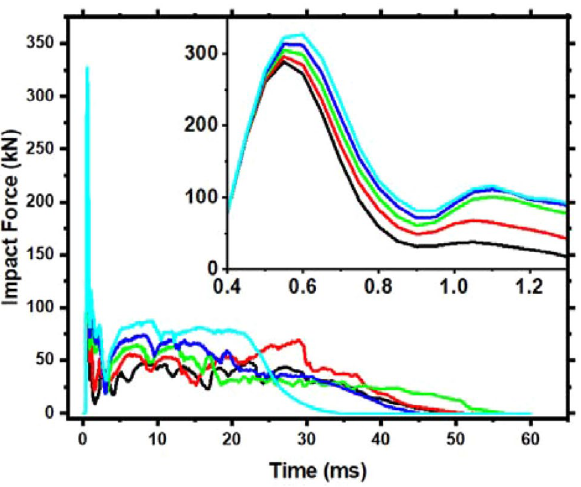
Figure 10. Impact force time-history curve for members with various longitudinal reinforcement ratios.